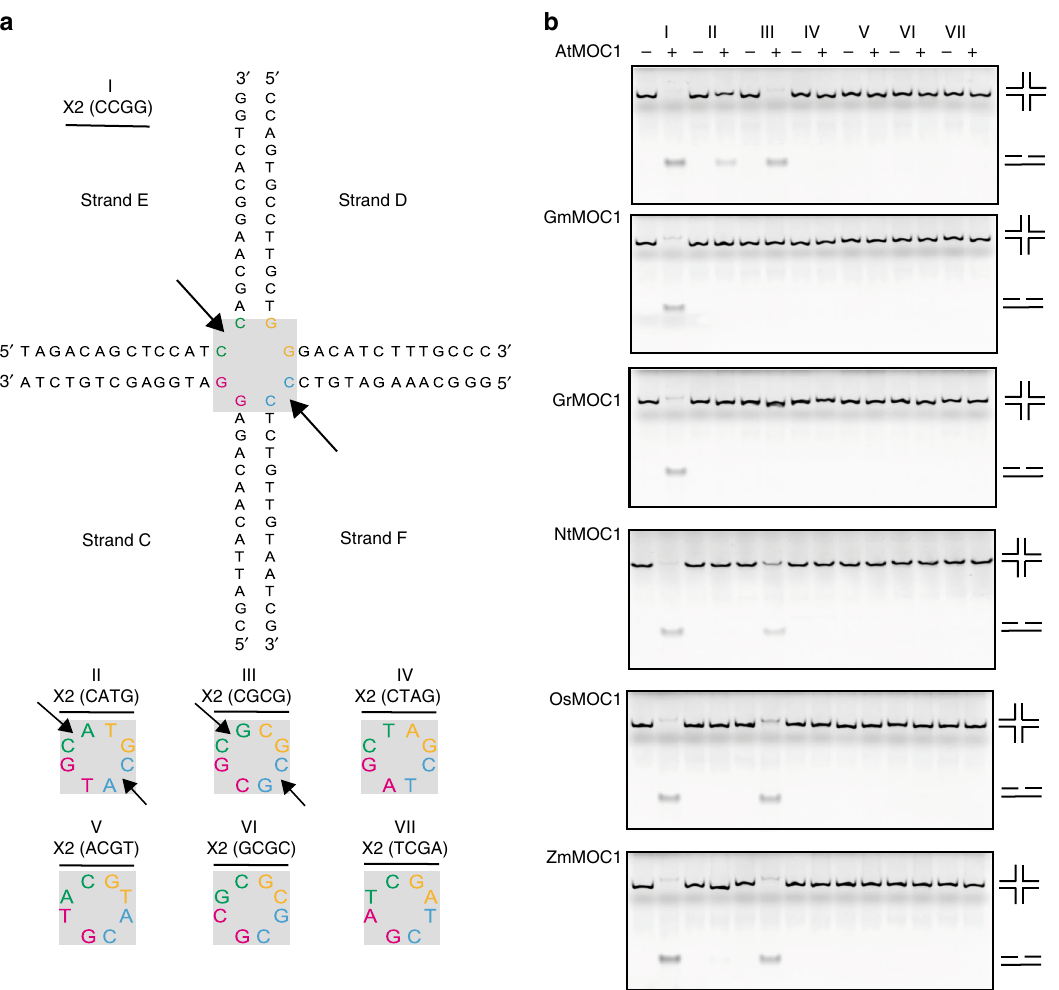
Fig. 1 Sequence-dependent HJ cleavage by chloroplast MOC1s. a Schematic drawing of the HJ substrate X2. X2 was prepared by annealing 4 DNA oligos. The upper panel shows the structure of X2 (CCGG). Two homologous base pairs are shaded in gray. The lower panel indicates X2s with variant CCGG cores. These X2s share identical nucleotides as X2 (CCGG) except the 2 bp homologous cores. These seven X2s are numbered sequentially (I-VII). Arrows indicate the cleavage site. b The sequence-speci fi c HJ resolution activity of MOC1 orthologs was examined. AtMOC1, GmMOC1, GrMOC1, NtMOC1, OsMOC1, and ZmMOC1 are MOC1s from Arabidopsis thaliana, Glycine max, Gossypium raimondii, Nicotiana tabacum, Oryza sativa , and Zea mays , respectively. The fi nal HJ concentration in each lane is 250 nM. The fi nal protein concentration of MOC1 is 1000 nM. The reactions were examined by native PAGE and visualized by GelRed staining. Labels on the top indicate the different X2 substrates used as shown in a . Source data are provided as a Source Data fi